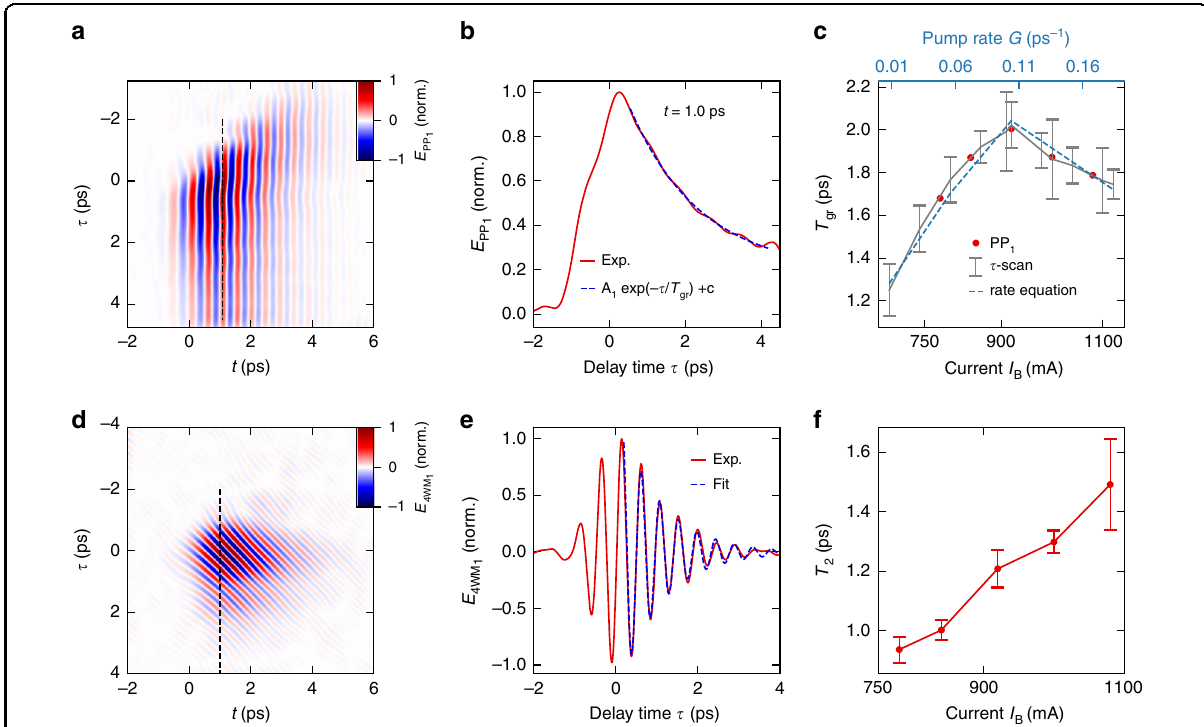
Fig. 3 Quantitative analysis of the coherent and incoherent dynamics in the QCL. a Back-transformed electric fi eld corresponding to the pump- probe signal E PP . b Slice through E PP ( t , τ ) at a delay time t = 1.0 ps (see black dashed line in a ). Blue dashed line: numerical fi t of function A 1 exp( − τ ⁄ 1 1 T gr ) + C . c Gain recovery time T gr of the QCL as a function of the bias current, extracted from the PP 1 signal (red dots) and the full nonlinear time domain signal (gray). The error bars display the uncertainty of the numerical fi t. Light blue dashed line: T gr as a function of the pump rate G , extracted from the rate equation model. d Back-transformed electric fi eld corresponding to the four-wave mixing signal E 4WM example delay time t = 1.0 ps (see black dashed line in d ). Blue dashed line: numerical fi t of function A 2 sin 2 π ν L τ þ ϕ ð the coherent population T 2 as a function of the bias current. The error displays the uncertainty of T 2 for different delay times between 0.45 and 1.75